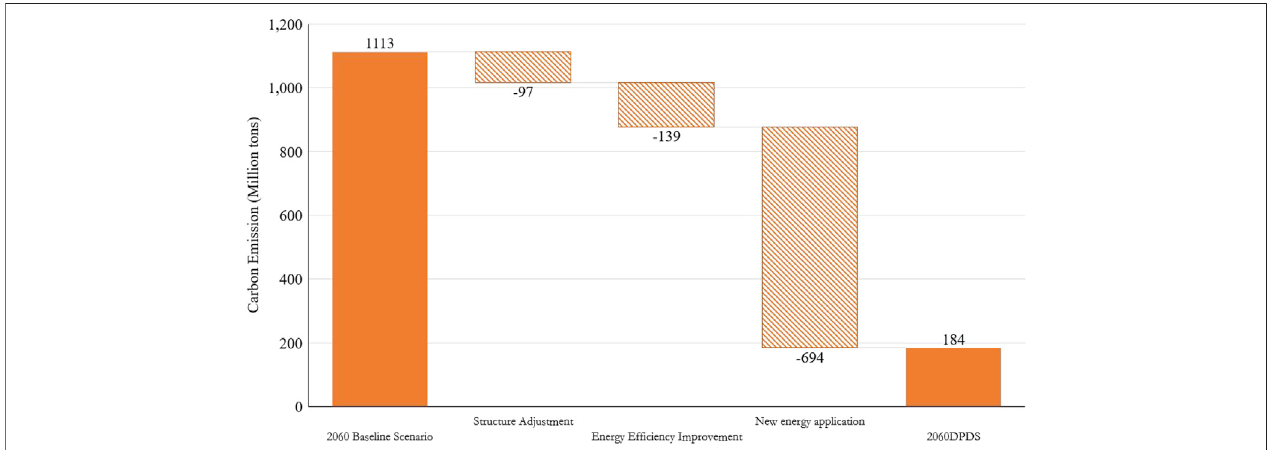
FIGURE 10 | Deconstruction of carbon emissions under the dual carbon policy scenario in 2060.